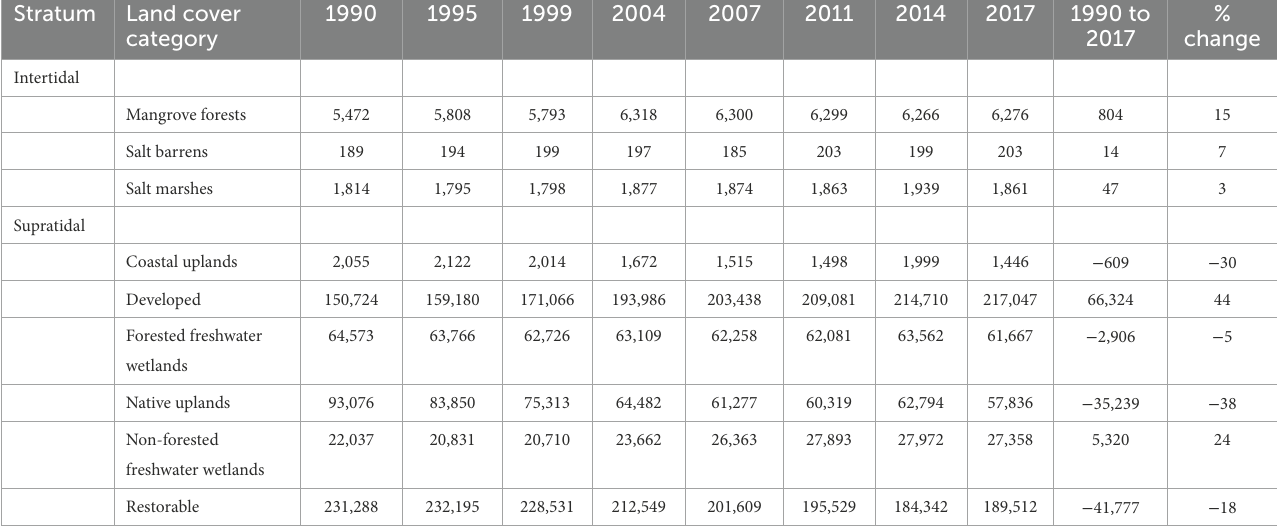
Columns show years with available data and the final two columns show the change and percent change from 1990 to 2017.